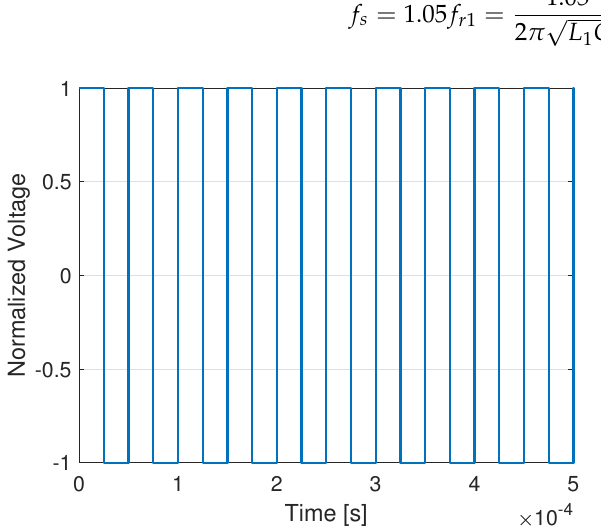
Figure 5. Voltage applied to the WPT